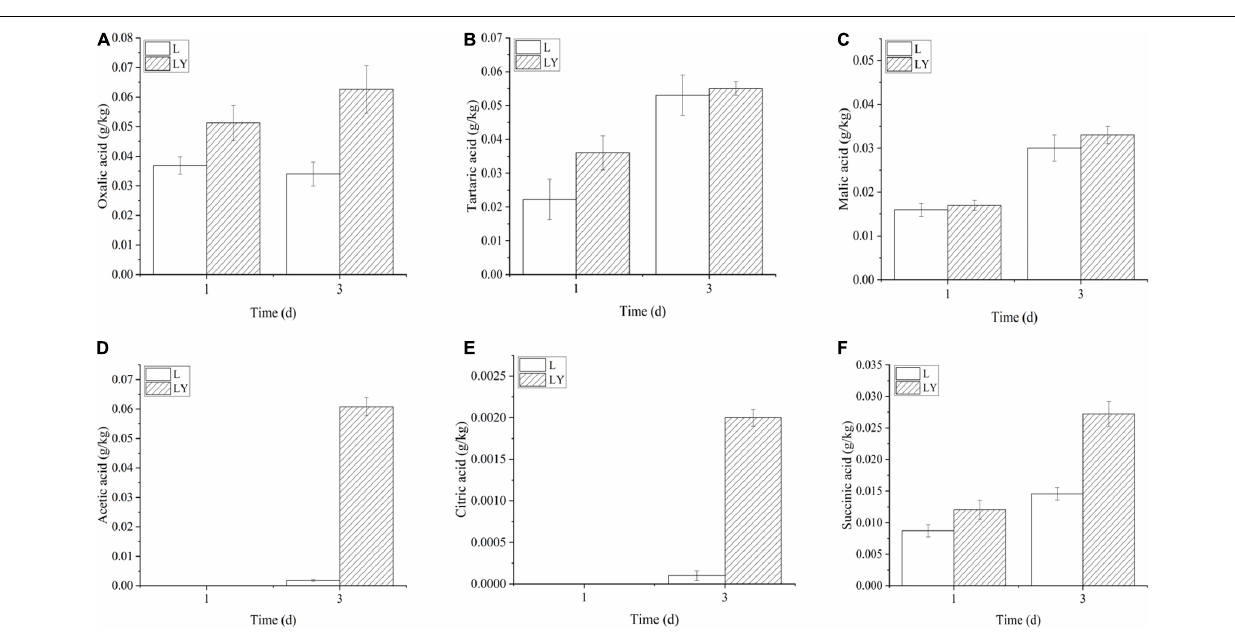
FIGURE 2 | The variations of organic acids in the fermentation period of 1 and 3 days of rice-acid inoculated with L. paracasei and mixed-culture with L. paracasei and K. marxianus [L means rice-acid inoculated with L. paracasei , LY means rice-acid inoculated with L. paracasei and K. marxianus . Organic acids include